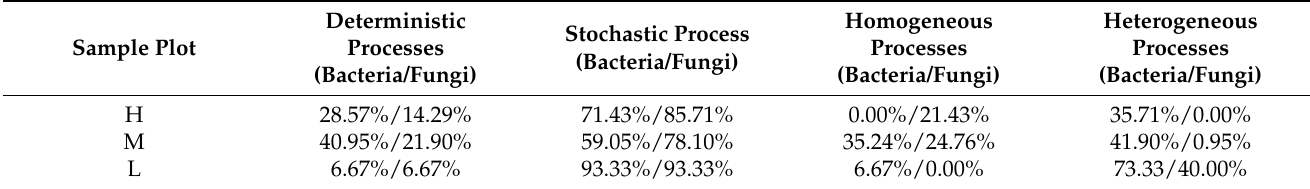
Table 4. Deterministic, random, homogenous and heterogeneous processes of microbial community construction in different water and salt